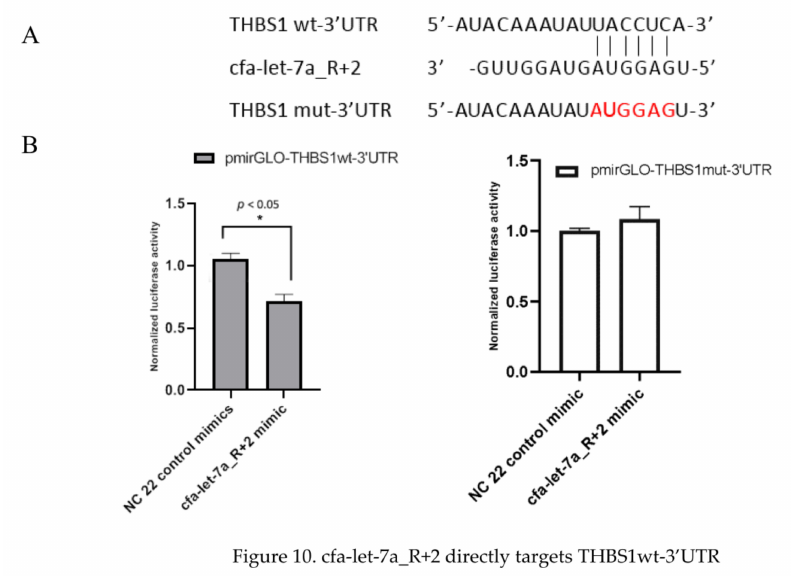
Figure 10. cfa-let-7a_R + 2 directly targets THBS1wt-3’UTR. ( A ) The wild and mutant binding sites between THBS1-3’UTR and cfa-let-7a_R + 2. The red representing the mutant binding sites. ( B ) cfa-let-7a_R + 2 inhibiting the luciferase activity of pmirGLO-THBS1wt-3’UTR but not that of pmirGLO-THBS1